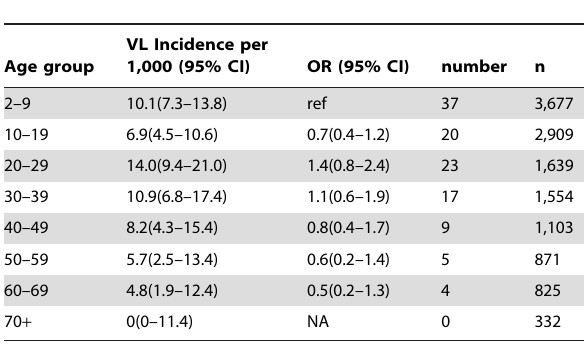
Table 3. Cumulative VL incidence by age group